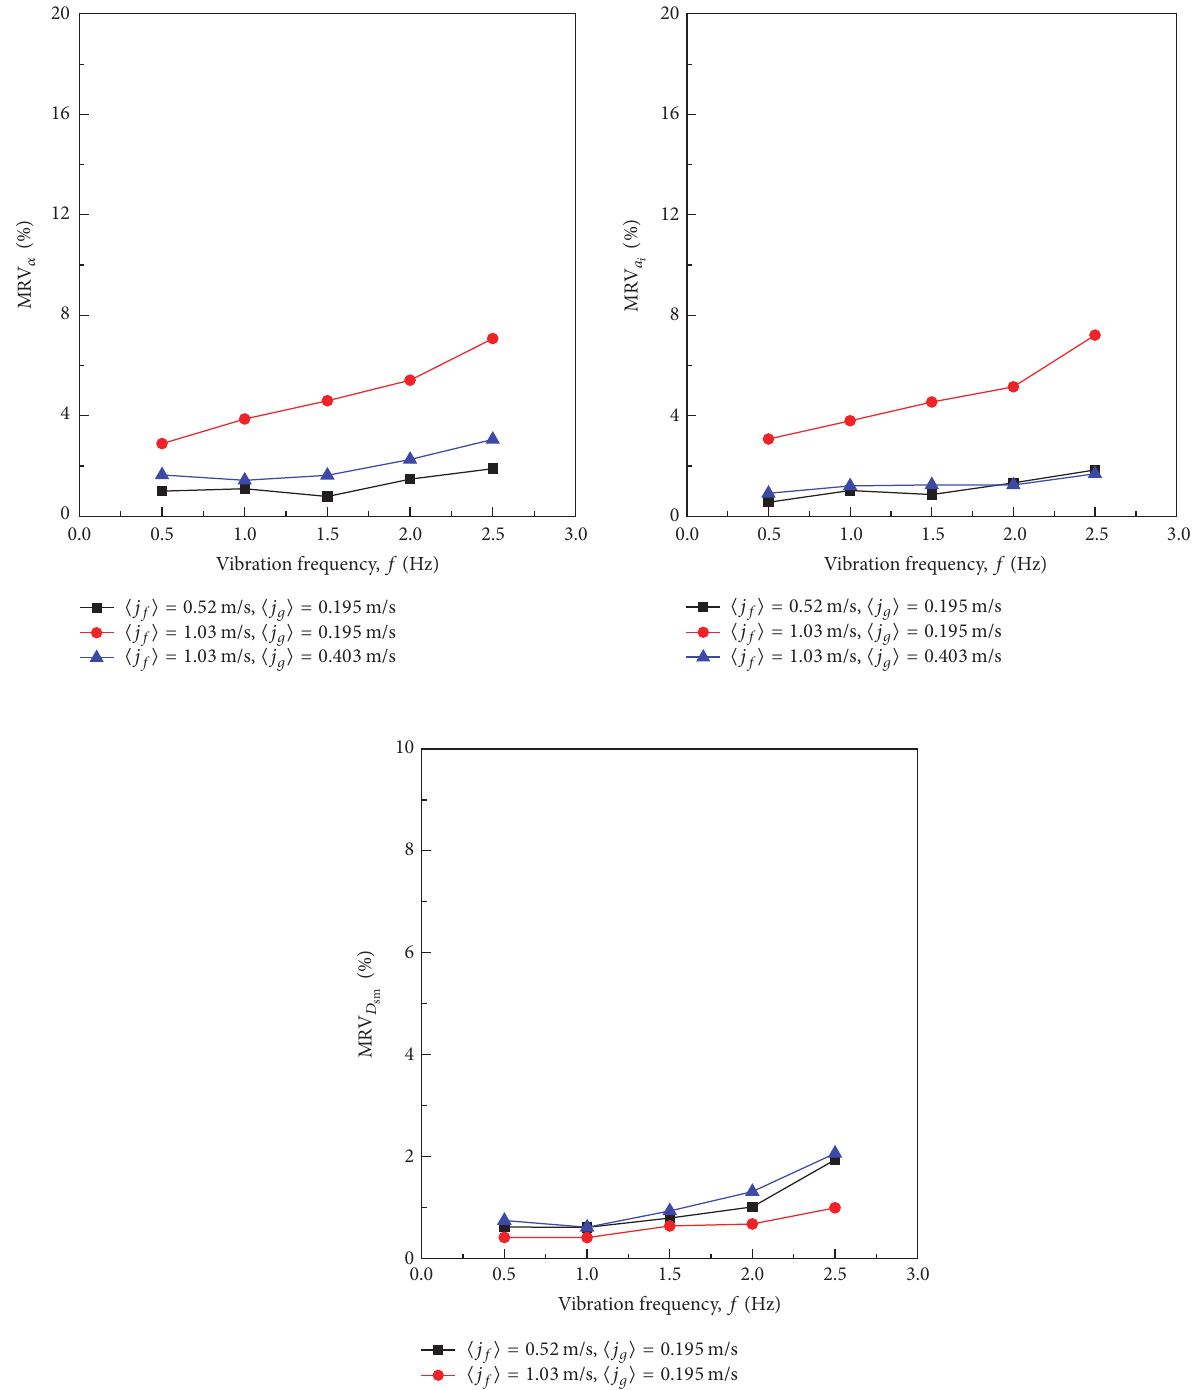
exceeds the additional bubble force caused by inertia and stage. With the bubbles moving to the outer wall, the radial bubbles begin to reverse their direction to move toward inner gradient of void fraction becomes higher and the turbulent wall. Therefore, the local void fraction starts to increase near dispersion force is enhanced. As the test section moves from 𝑆 = 0 , the vibration acceleration keeps its 𝑆 = 𝑆 the inner wall region and decrease near the outer wall at 𝑚1 to a certain moment in this stage. The opposite trend can be negative direction but its value decreases from |𝑎 𝑚2 | to almost 0. During this stage, the turbulent dispersion force gradually expected during the other half period of the vibration